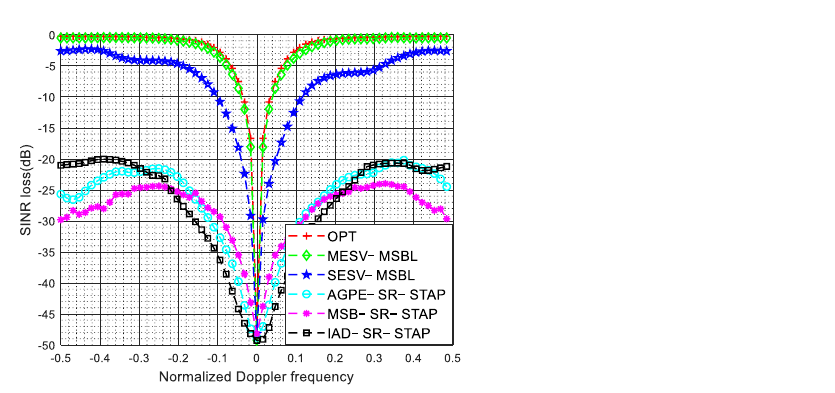
Figure 14. SINR loss comparison of different methods in the presence of arbitrary array